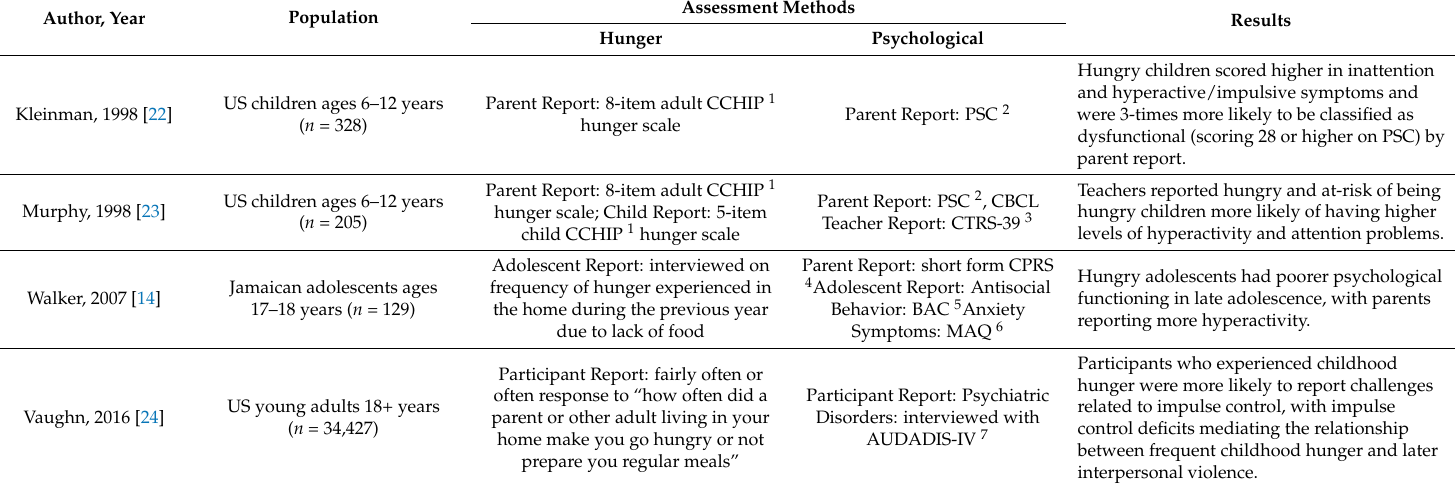
Table 2. Comparison of literature characterizing associations between hunger and symptoms of ADHD in a pediatric